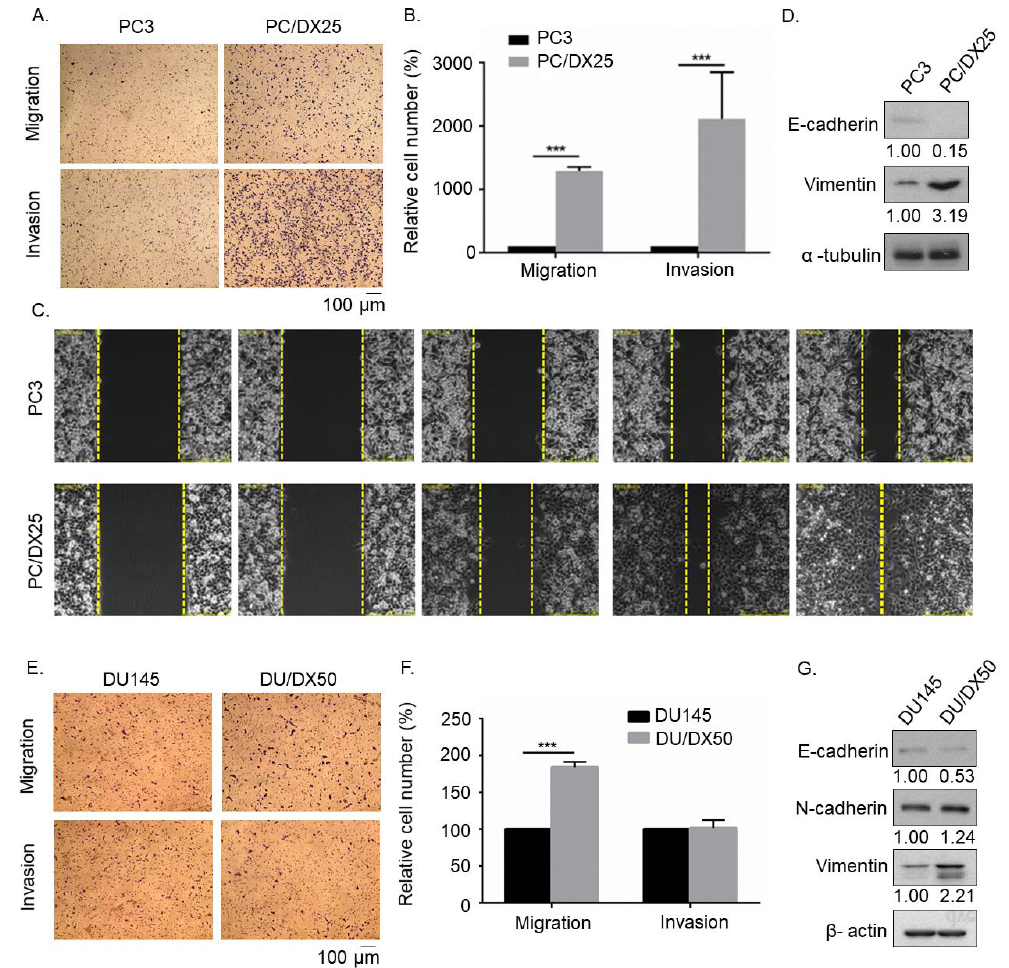
Figure 1. Transwell assay and wound healing assay revealed that docetaxel-resistant PCa cells exhibited higher migration and invasion ability as compared to parental PCa cells. ( A ) Images of PC-3 and PC/DX25 cells in migration and invasion transwell assays. ( B ) Quantification of cell migration and invasion of PC3 cells and PC/DX25 cells in (A). ( C ) Cell mobility of PC-3 and PC/DX25 cells was determined by wound healing assay at 0, 4, 8, 12, 16 h after the scratching. ( D ) Protein expression level of E-cadherin and vimentin was determined by Western blotting. The α -tubulin was used as loading control. ( E ) Images of DU-145 and DU/DX50 cells in migration and invasion transwell assay. ( F ) Quantification of cell migration and invasion of DU-145 cells and DU/DX50 cells in (E). ( G ) Protein expression level of E-cadherin and vimentin was determined by Western blotting. The β -actin was used as loading control. Asterisk *** represents statistically significant difference of p value <